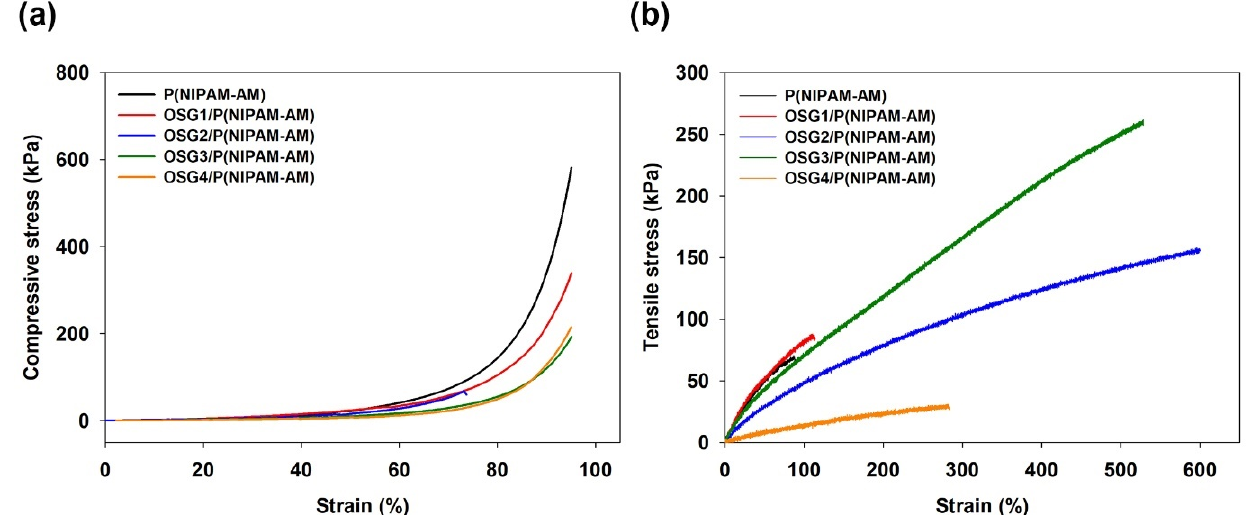
Figure 7. Mechanical properties of hydrogels: hydrogel compression strength test ( a ) and hydrogel tensile properties test ( b ).